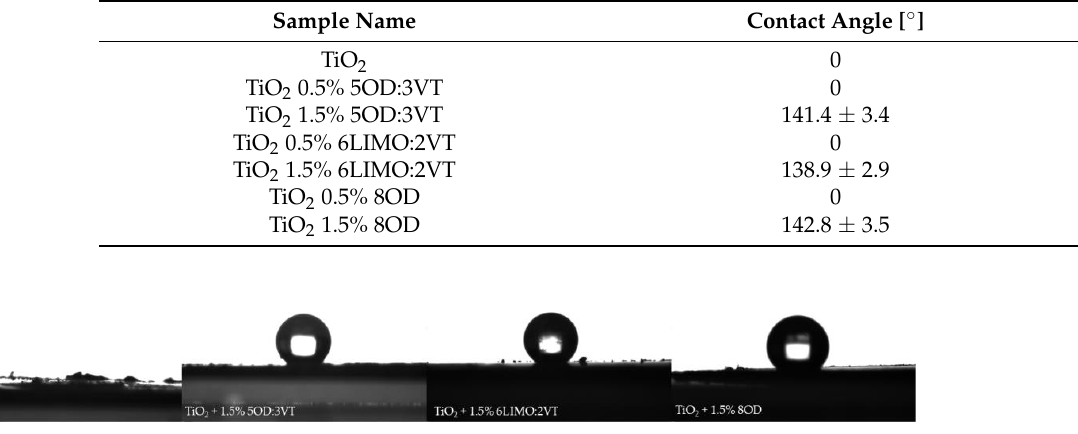
Figure 6. Images of water droplets during sessile drop analysis for composites. Table 6. Water contact angle of composites [°]. Code